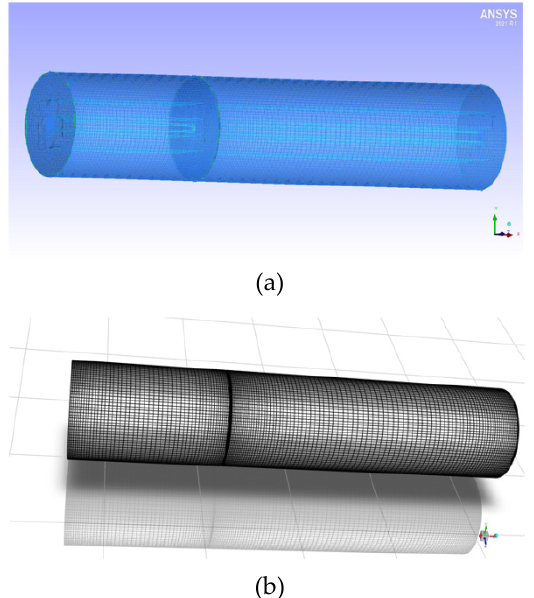
Figure 9. ( a ) Mesh generation for sample 1, ( b ) Physical model for sample Figure 9 (a). Mesh generation for sample 1, (b). Physical model for sample 1.